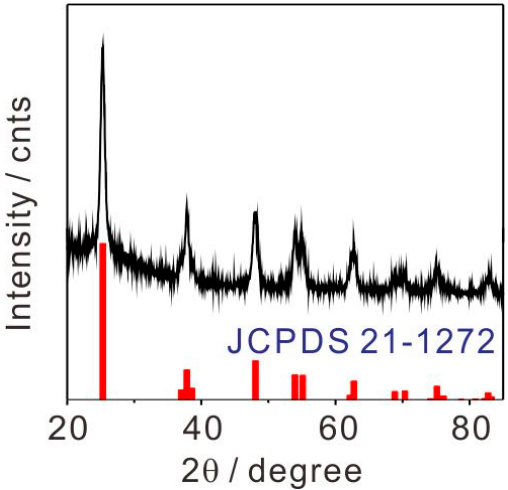
Figure 2. XRD patterns of TiO 2 and the standard XRD patterns of anatase-phase TiO 2 (JCPDS 21-1272).